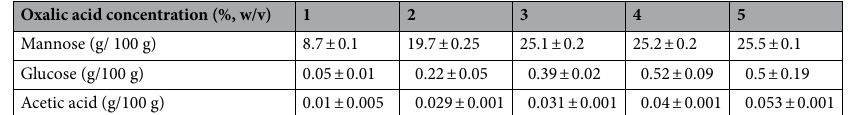
Oxalic acid concentration (%,